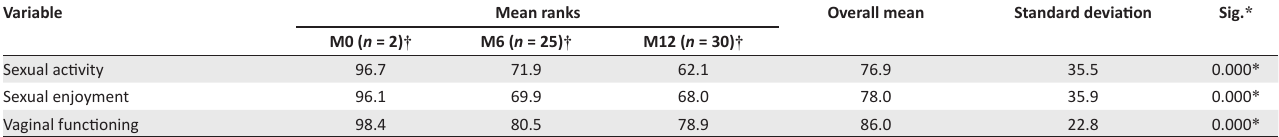
TABLE 6: Sexual functioning reported by the different groups ( n = 153).